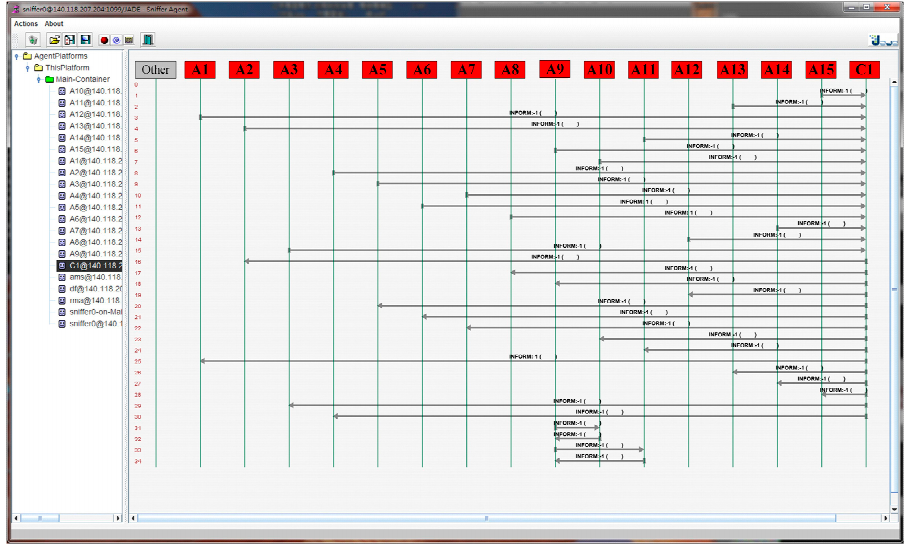
Figure 12. Interactive communication of the agents under grid-connected mode, fault occurrence at Bus 1 and failure trip of